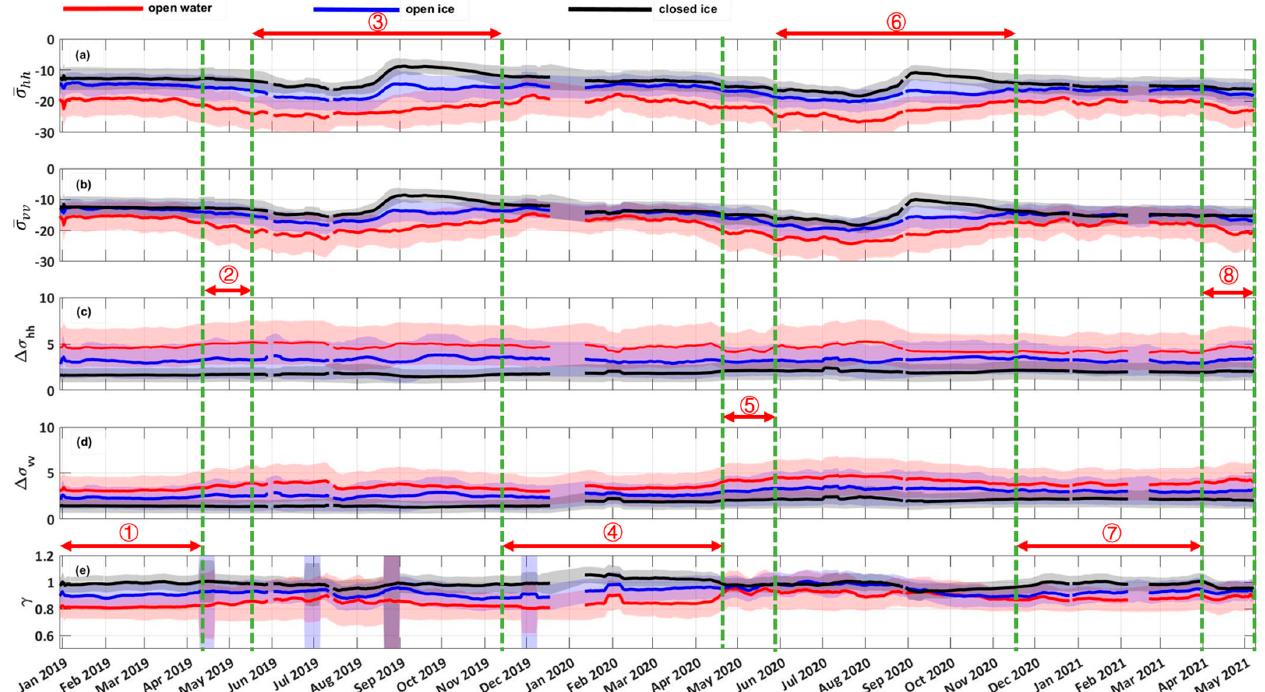
Figure 6. The mean values (solid lines) and standard deviations (shaded areas) of Arctic sea ice distribution feature parameters from 1 January 2019 through 10 May 2021 ( a ) σ hh , ( b ) σ vv , ( c ) ∆ σ hh , ( d ) ∆ σ vv , ( e ) γ . The red, blue, and black marked results represent open water, open ice, and closed ice, respectively. The double arrows represent the most significant feature parameters in different time periods.